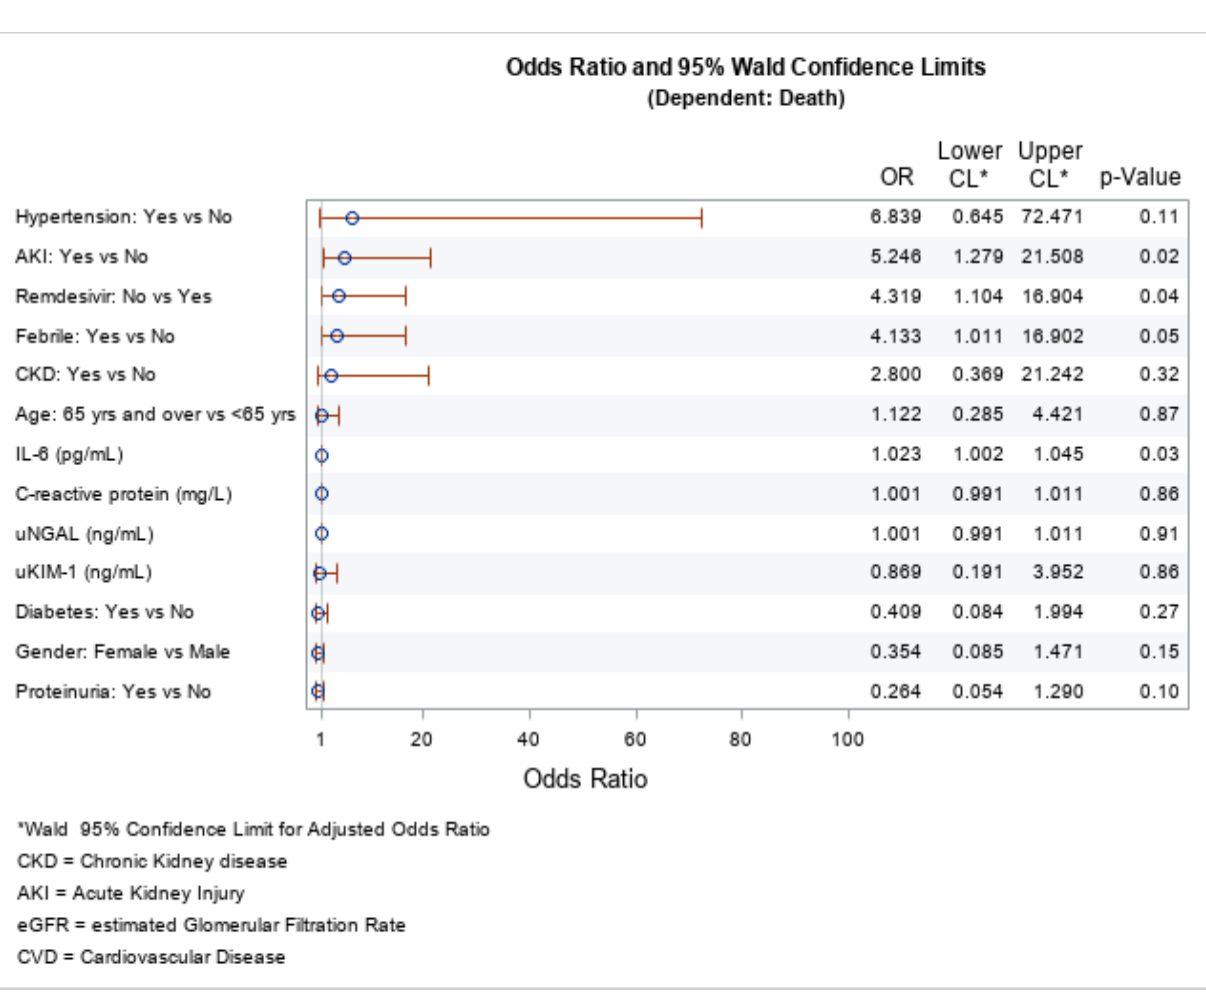
Figure 3. Odds ratio for risk factors for COVID-19-related death.